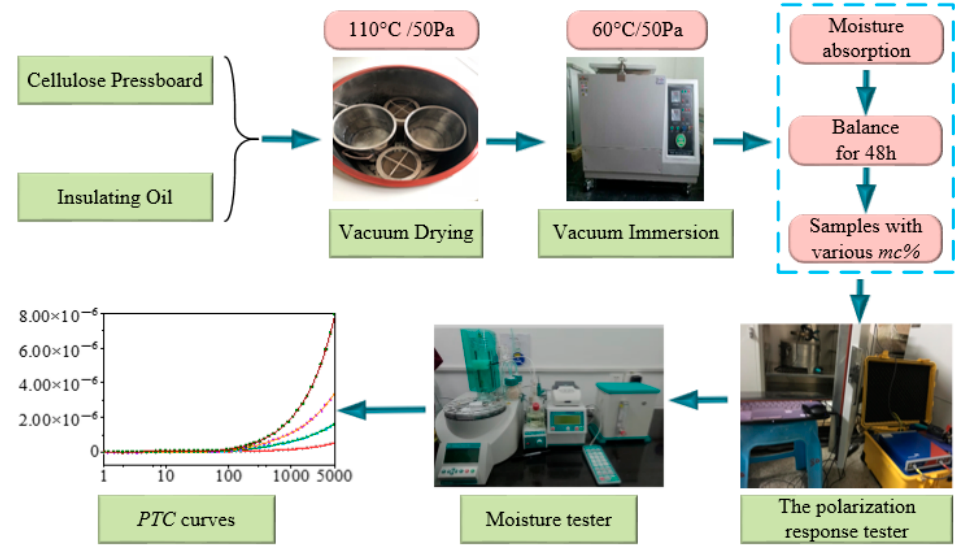
Figure 1. Pretreatment and testing process of oil-immersed cellulose pressboards.